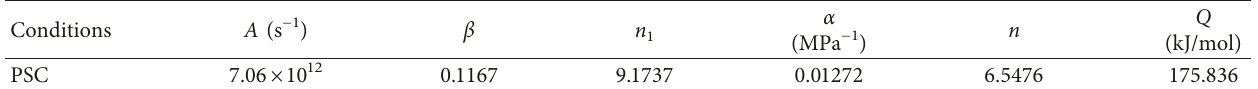
Figure 3: Relationships between (a) ln _ ε - σ ; (b) ln _ ε -ln σ ; (c) ln _ ε -ln [ sinh ( ασ )] ; and (d) ln [ sinh ( ασ )] - ( 1/ T ) for PSC. Table 1: Values of material constants of the AA6061 alloy under PSC